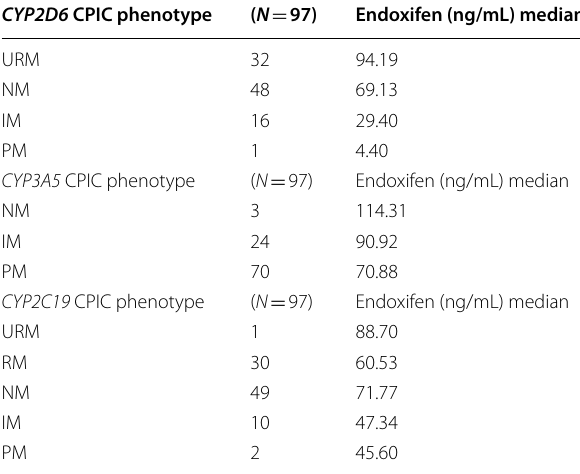
Table 6 Plasma concentrations of Endoxifen in subjects with CYP2D6 , CYP2C19 and CYP3A5 genotype CYP2D6 CPIC phenotype